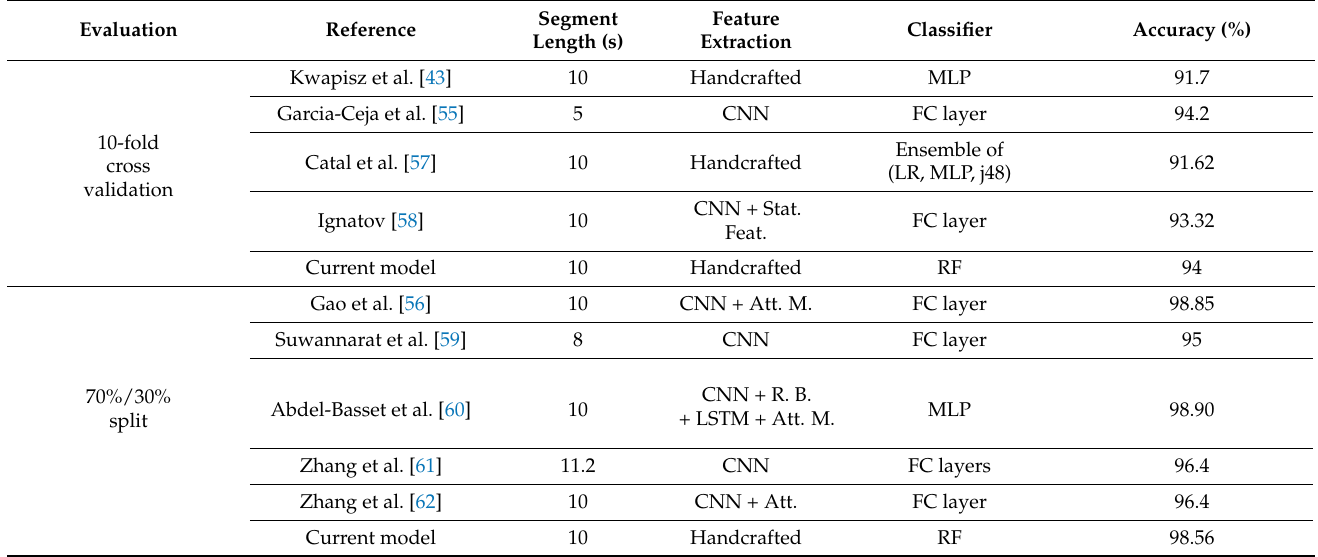
Table 7. Applied model results for WISDM dataset. MLP: multi-layer perceptron. LR: logistic regression. Stat. Feat.: statistical features. Att. M.: attention mechanism. R. B.: residual block. LSTM: Long short-term